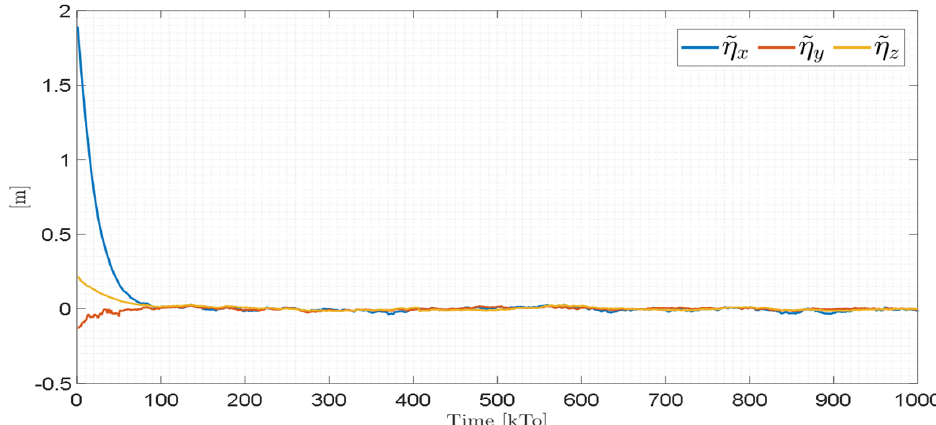
(cid:0) (cid:1) (cid:101) η x , (cid:101) η y , (cid:101) η z